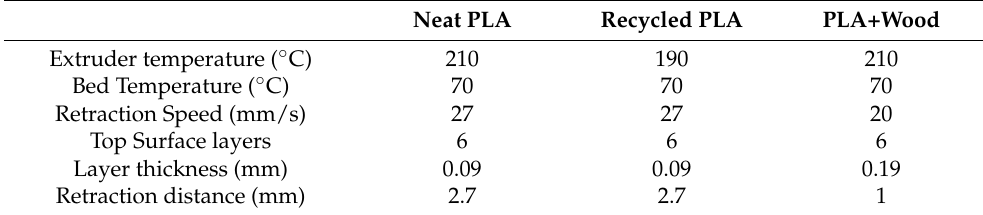
Table 6. Final processing conditions used to print DMA specimens.